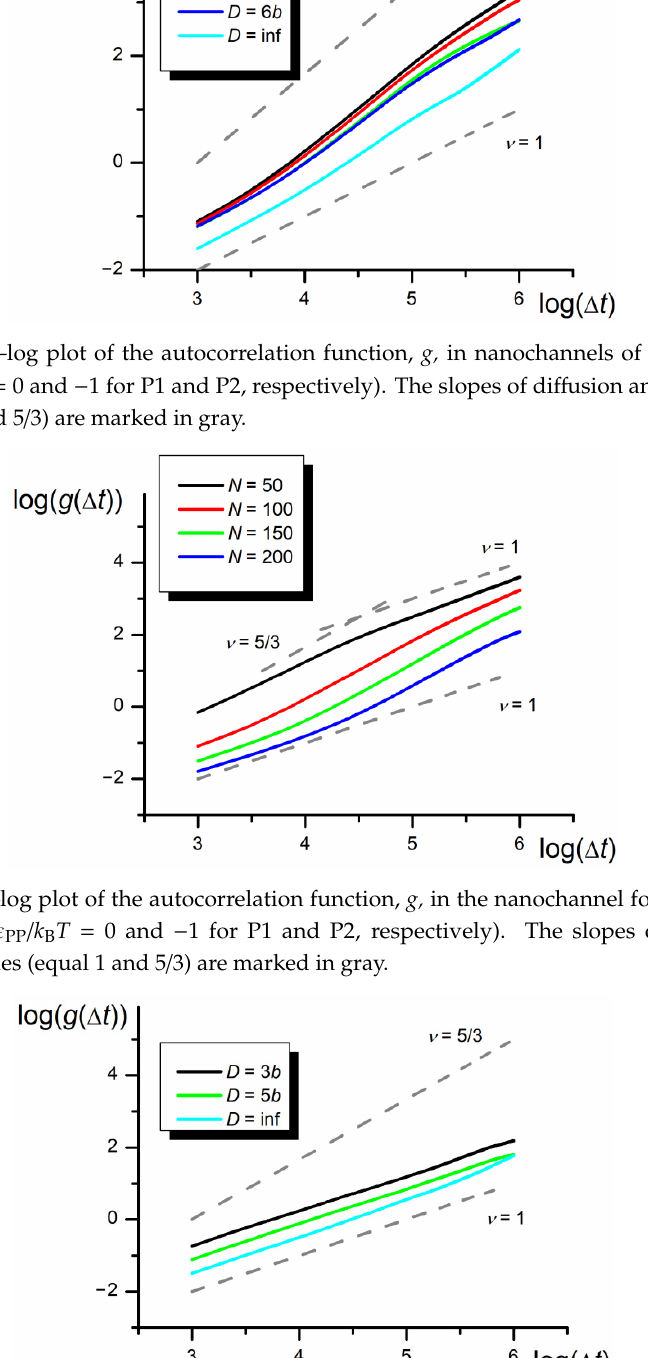
Figure 8. The log–log plot of the autocorrelation function, g, in the nanochannel and 3D space ( N = 100, ε PP / k B T = 0 for P1 and P2—athermal solution). The slopes of diffusion and quasi-ballistic modes (equal 1 and 5/3) are marked in gray.